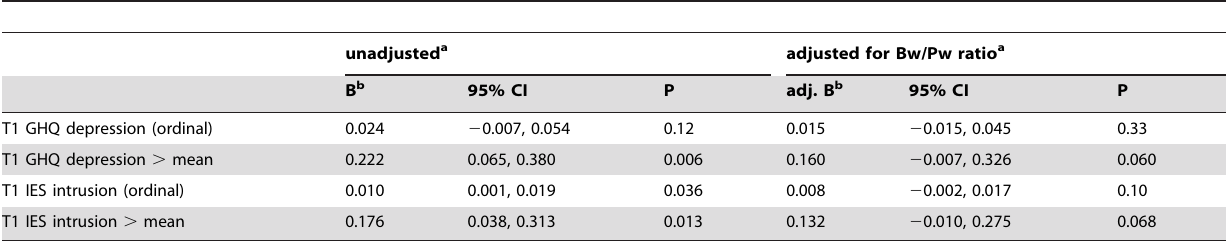
Table 4. Linear regression exploring the role of birthweight/placental weight ratio on the association between distress measures and ln-transformed normalized umbilical vein blood